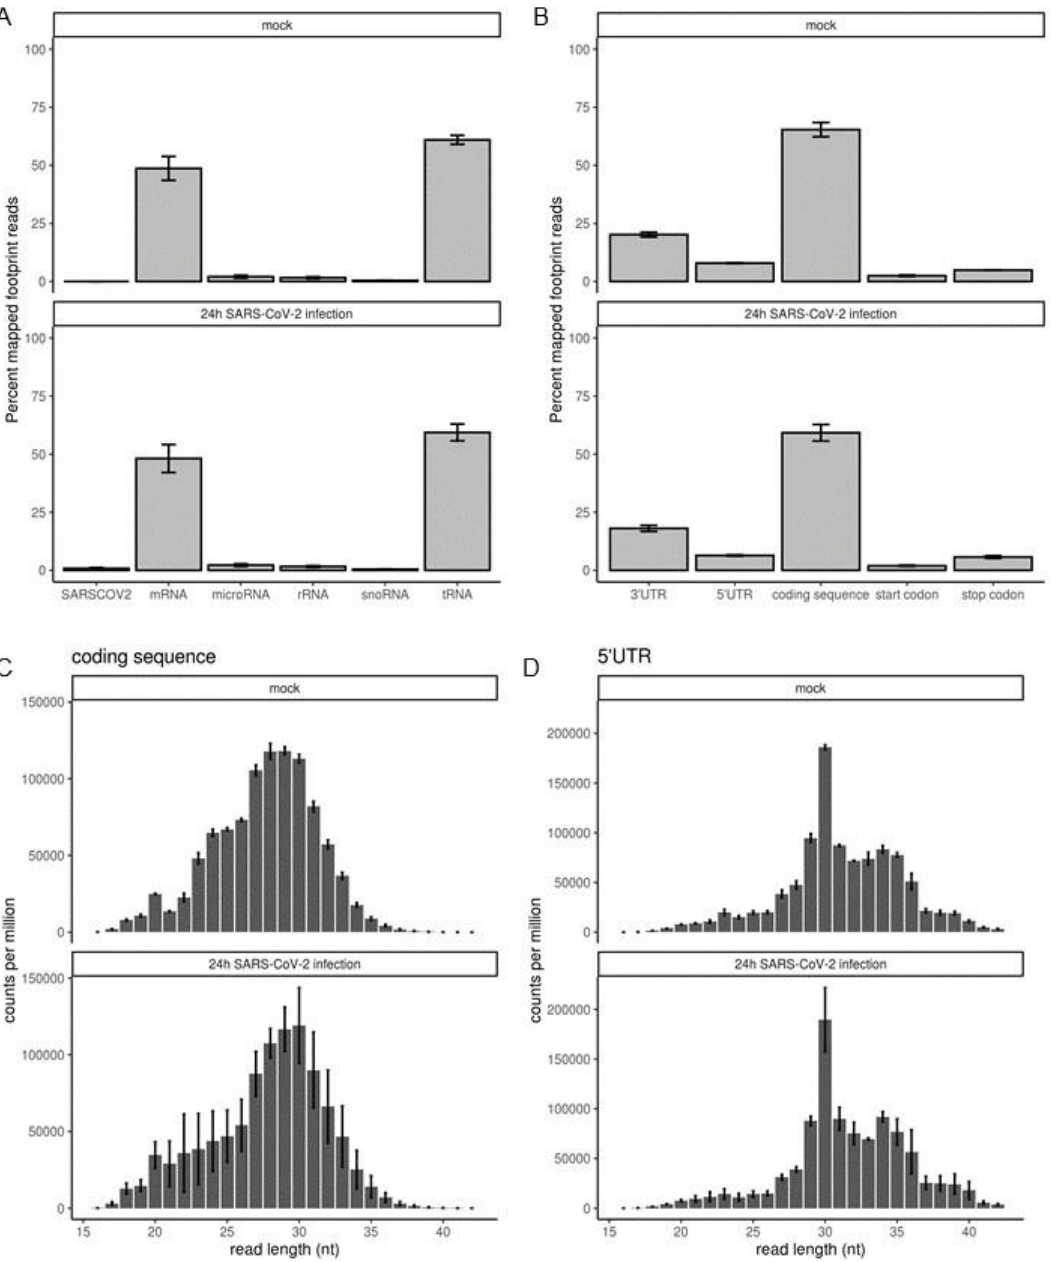
Figure 3. MNAse digestion of cell extracts yields 30 nt long CDS-mapped ribosome footprints. ( A ) Percentage of reads mapping to indicated RNA species in mock and SARS-CoV-2 infected cells at 24 h. ( B ) Percentage of non-coding RNA filtered reads mapping to indicated gene-level features in mock and SARS-CoV-2 infected cells. ( C , D ) Read-length counts per million read distribution in coding sequence and 5′ untranslated regions (UTR).